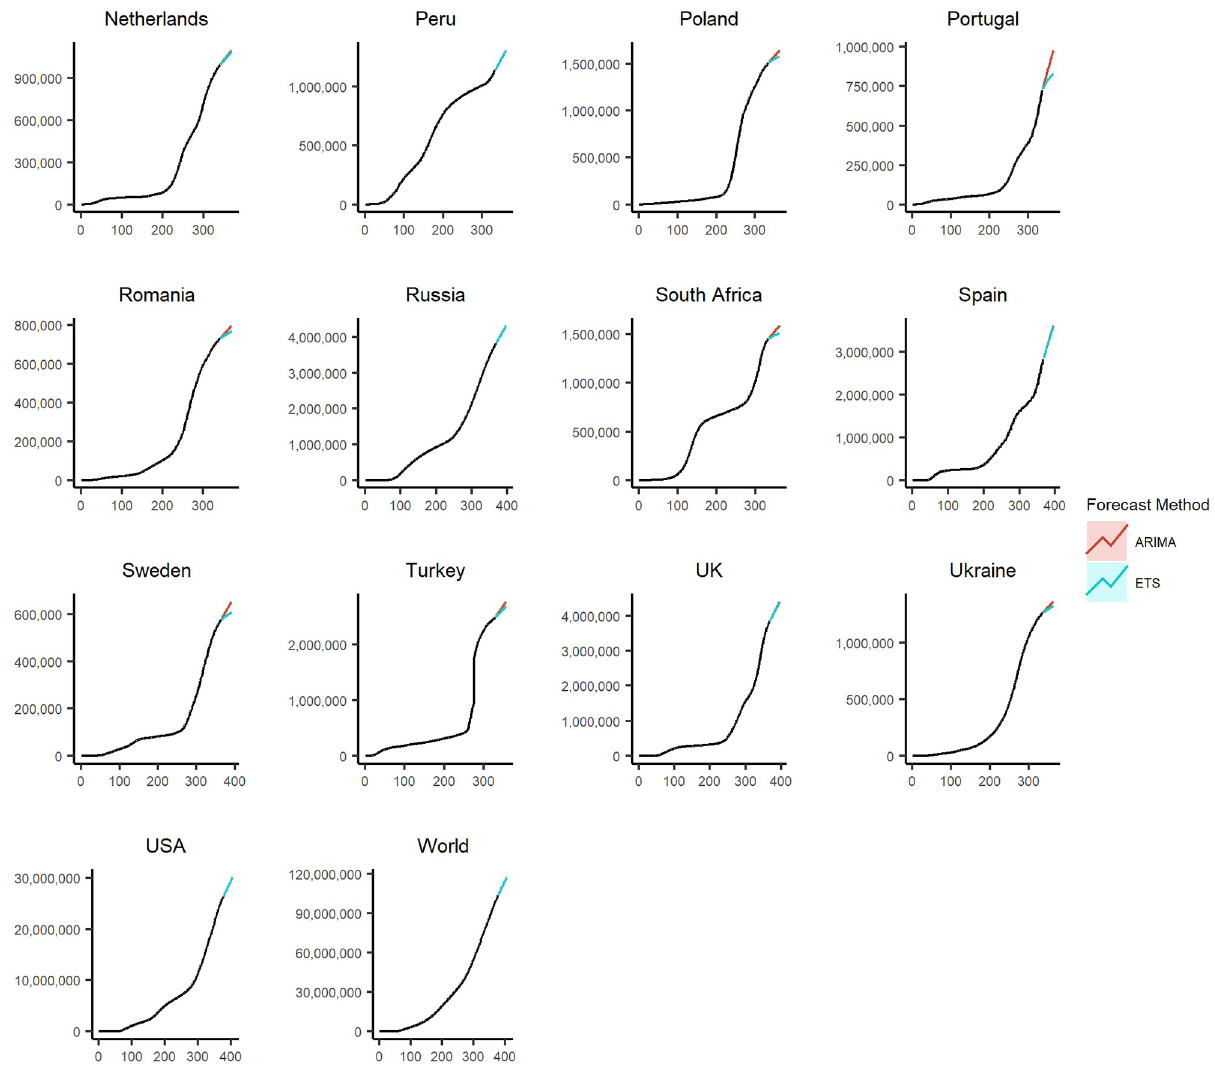
Fig 6. The 4 weeks ahead forecasts for 13 of the 29 countries with the highest cumulative COVID-19 cases and at the aggregated level for the entire world using the ARIMA and ETS methodologies.